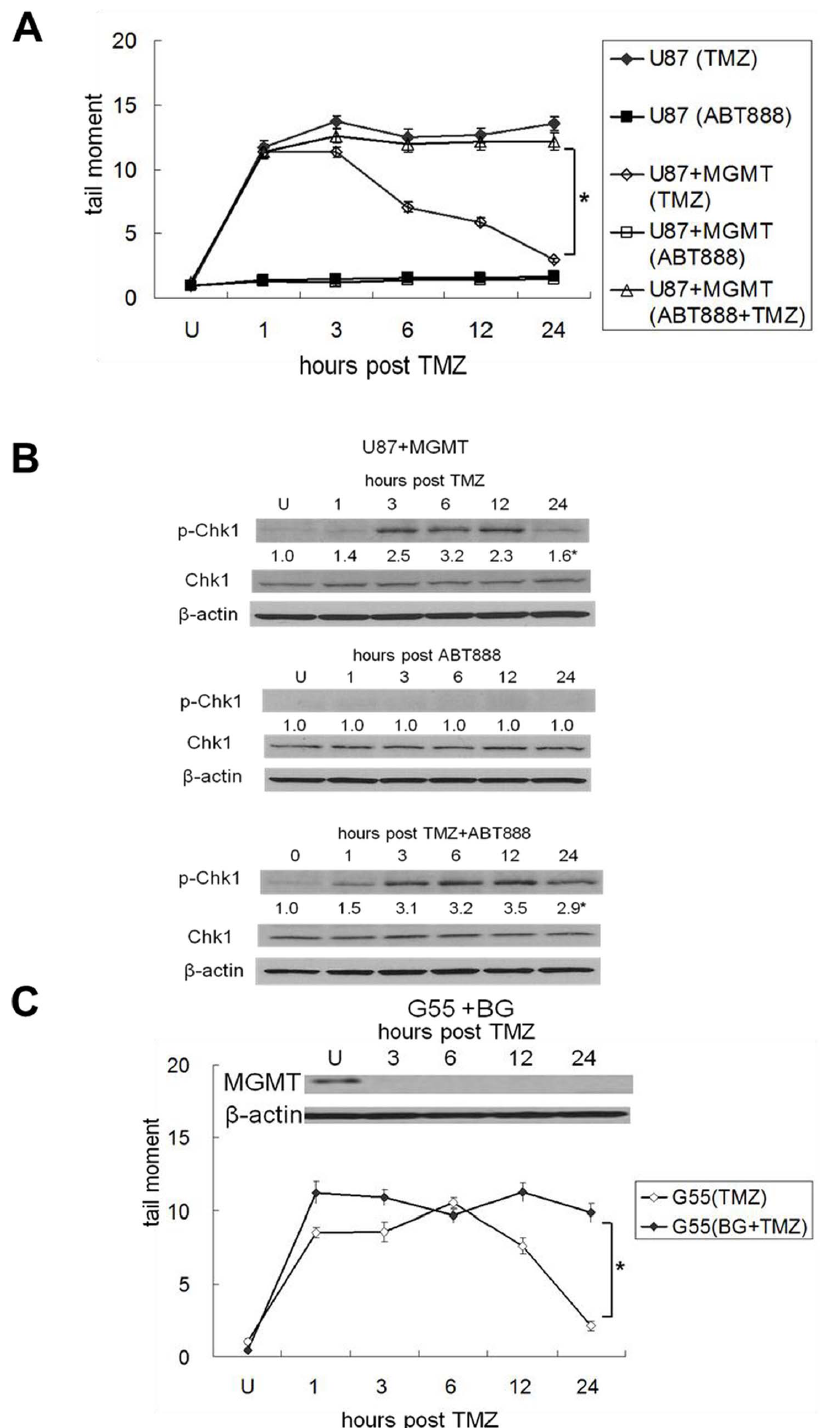
Figure 5. TMZ-induced Chk1 activation is associated with TMZ-induced ALD. U87 or U87 + MGMT cells (A, B) were incubated with TMZ (100 m mol/L, 3 hours), ABT888 (5 m M, continuous), or both (one hr ABT pre-incubation followed by the 3 hr TMZ exposure). Cells were then washed and incubated in drug-free (for TMZ groups) or ABT-containing (for the ABT or ABT + TMZ groups ) media and harvested 1–24 hrs later for analysis of tail moment by single cell alkaline gel electrophoresis (A), or pChk1, Chk1, MGMT, and b -actin expression by Western blot (B). Tail moment values are the mean + standard error for three independent experiments. Similar tail moment and Western blot analyses were performed in G55 cells and G55 cells depleted of MGMT by a one hr pre-exposure to BG (5 m M) 1–24 hrs post TMZ (100 m mol/L, 3 hours) exposure (C). Mean fold induction of protein expression was based on densitometric measurements and is shown (relative to untreated controls) below the relevant immunoreactive bands. *, p , .05.